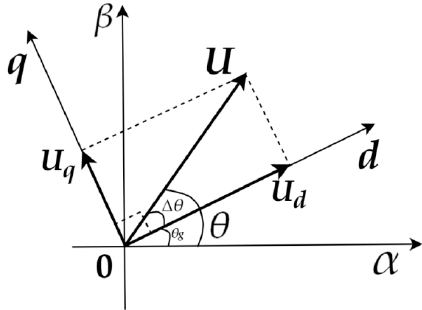
Figure 10. A schematic diagram of pre-synchronization process.